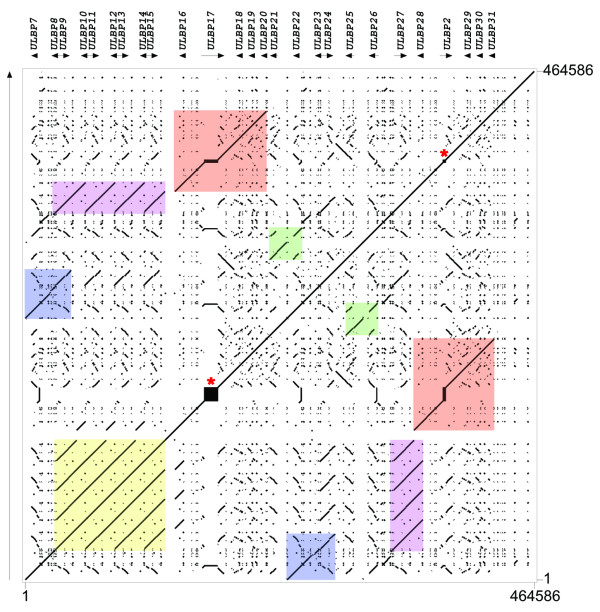
Internal sequence identity plot of the major ULBP cluster. Sequence numbers displayed on the X- and Y-axes indicate alignment orientation, originating in the lower left corner. The center line represents identity; other lines indicate regions of internal sequence identity. Genes are annotated above the figure with arrows indicating orientation. Nucleotide sequences used to construct the major ULBP cluster are listed in Table 1. The duplication of ULBP28-ULBP31 to form ULBP16-ULBP20 is within the red shaded area. The cattle specific repeat regions within ULBP17 and ULBP2 are indicated by red asterisks. The duplication of ULBP7-ULBP9 corresponding to ULBP22-ULBP24 is within the blue shaded area. The duplication of ULBP21-ULBP22 corresponding to ULBP25-ULBP26 is within the green shaded area. The tandem duplications of ULBP9 and ULBP10, ULBP11 and ULBP12, ULBP13 and ULBP14, and ULBP15 are within the yellow shaded area, and lines showing their similarity to the ULBP27 region are within the violet shaded area.